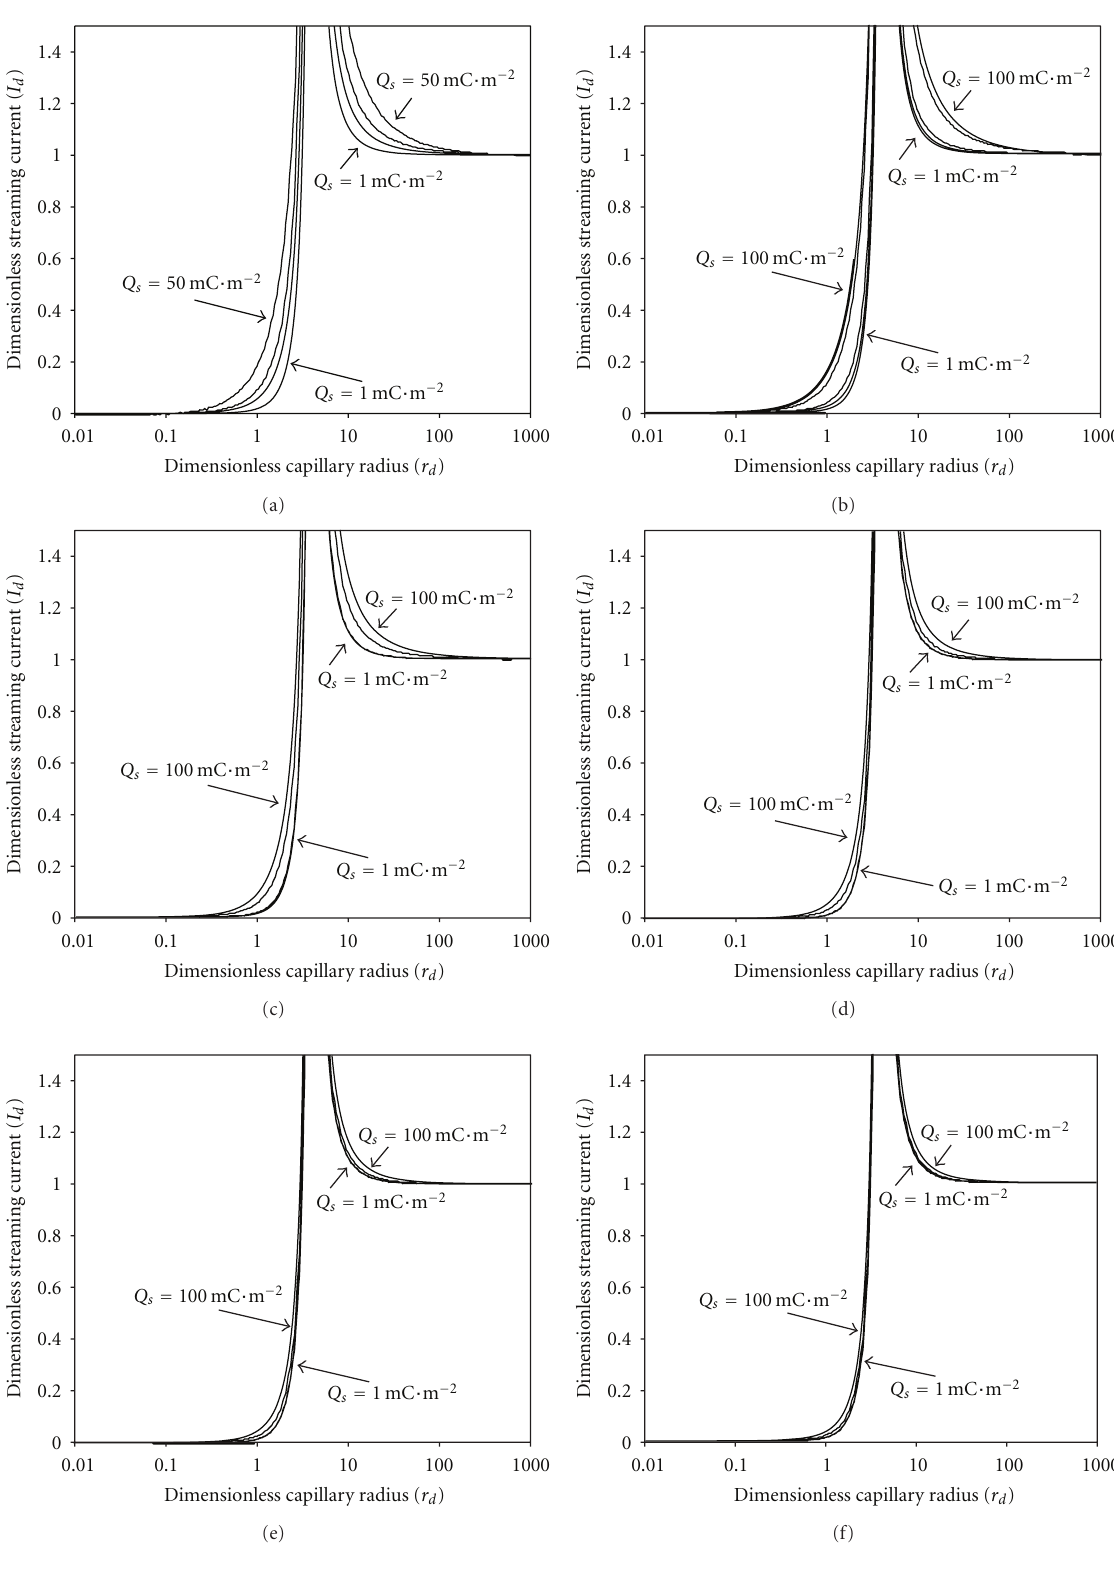
Figure 3: Dimensionless streaming current ( I d ) as a function of dimensionless pore radius ( r d ) for concentration values of (a) 0.001 M; (b) 0.01M; (c) 0.1 M; (d) 0.5M; (e) 1M; (f) 2 M. Curves denote surface charge values of 1, 5, 10, 50, and 100mC · m − 2 , with curves ordered between the maximum and minimum values indicated on the plots. The 100 mC · m − 2 case is not shown in Figure